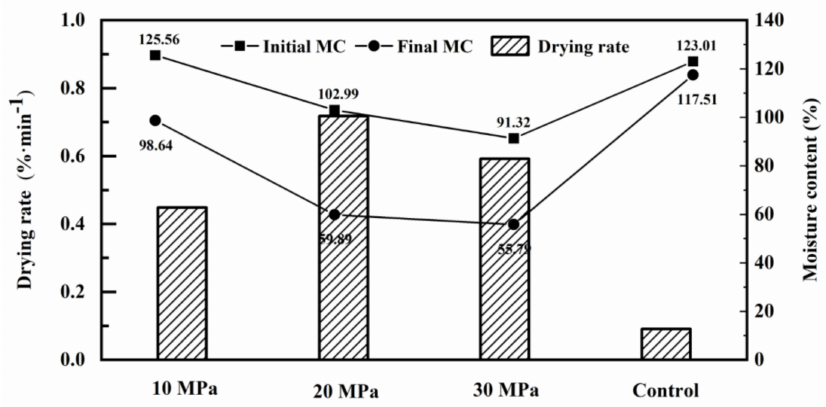
Figure 4. Drying rate and moisture content for 1 h SCD at di ff erent